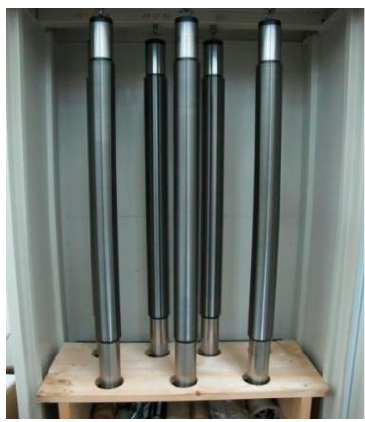
Figure 12. Machining completed for the preferred screw.